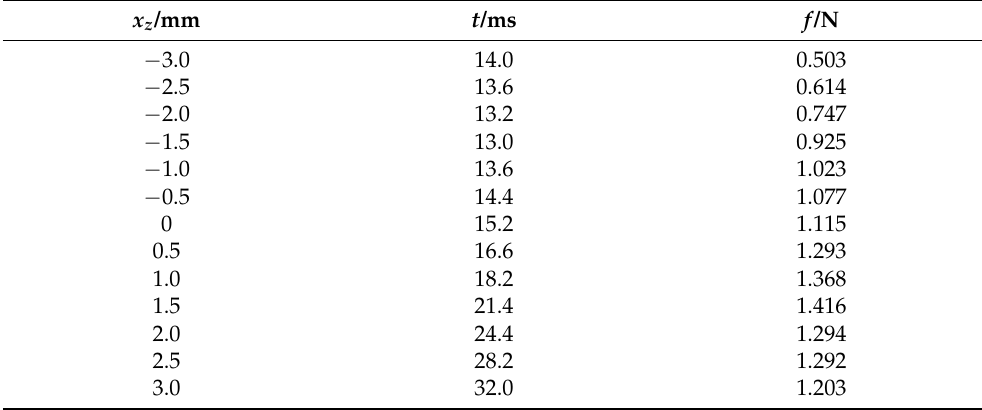
Table 2. Electromagnetic force and response time at different MIR